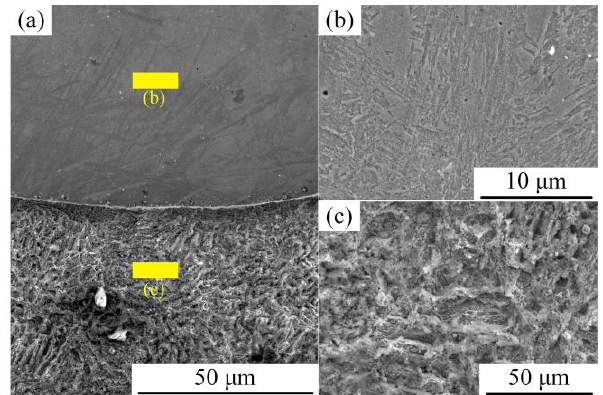
Figure 9. Surface corrosion morphology of modified plate. ( a ) Interface of the surfacing layer and the base material; ( b ) corrosion morphology of stainless steel; and ( c ) corrosion morphology of the base material.